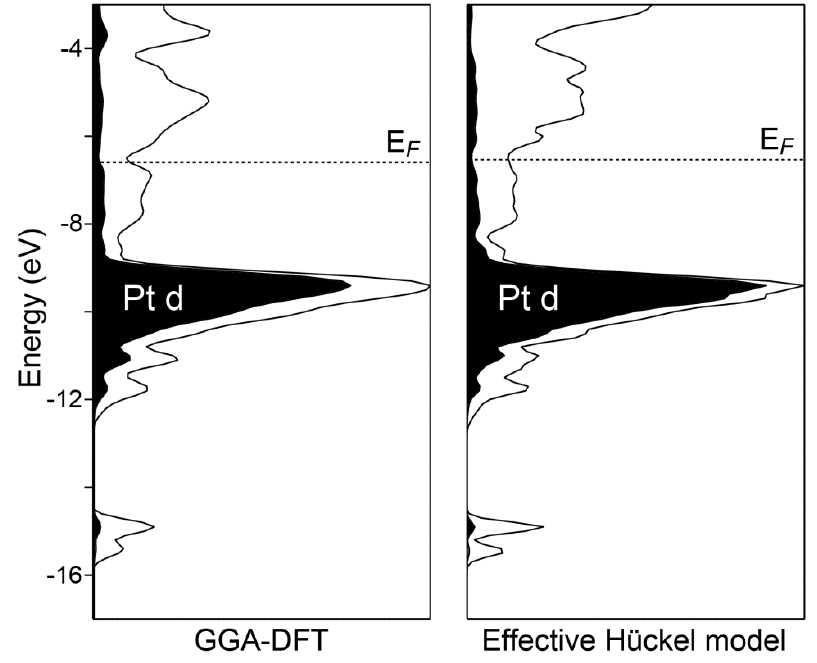
Figure 2. The electronic density of states (DOS) distributions of Ca GGA-DFT and a DFT-calibrated Hückel model. The DOS curves have been treated with Gaussian broadening to make their general features most